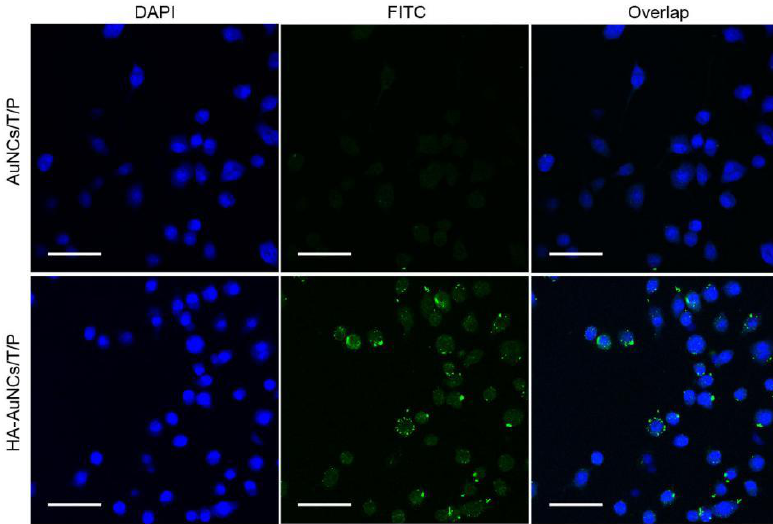
Figure 3. RAW 264.7 cells were incubated with AuNCs/T/P and HA-AuNCs/T/P for 4 h, and cellular uptake was recorded by laser confocal microscopy (scale bar: 25 μm).